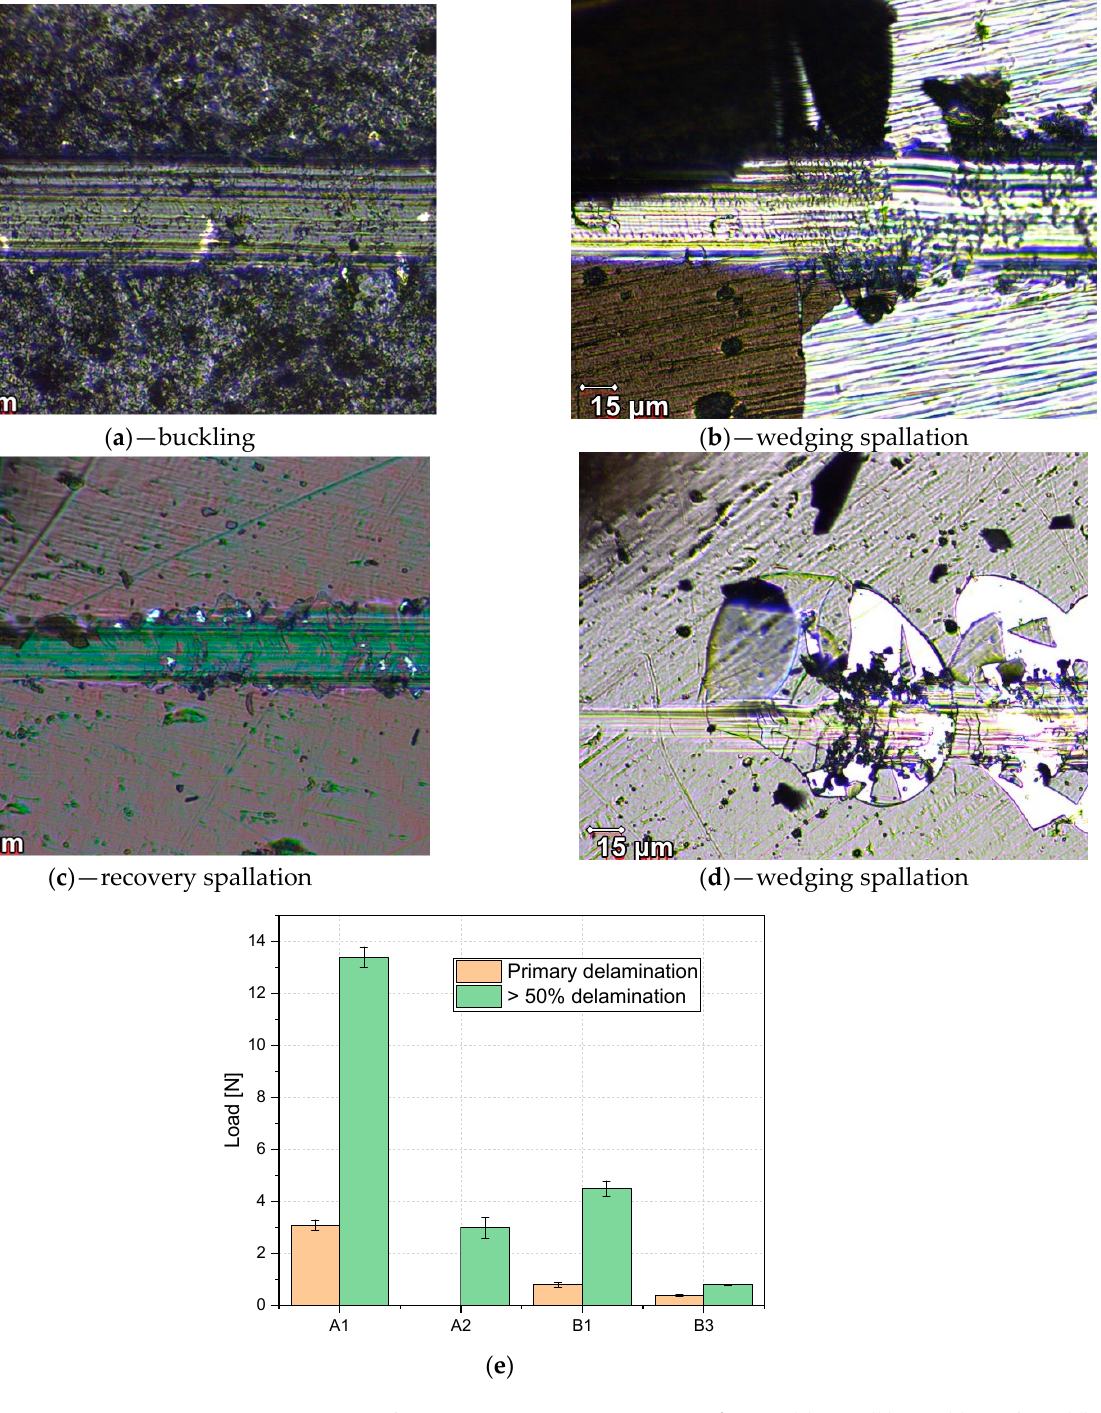
Figure 8. Post-scratch test measurements overview for A1 ( a ), A2 ( b ), B1 ( c ), and B3 ( d ); loads attributed to first delamination and over 50% coating removal ( e ).